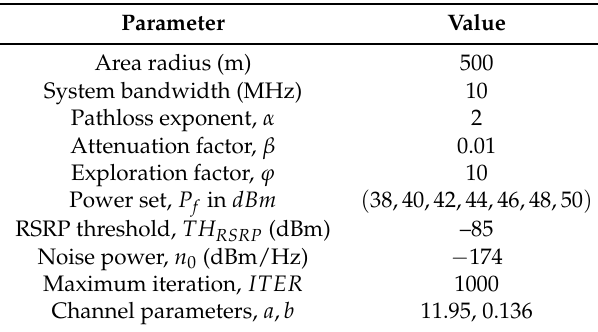
Table 1. Simulation